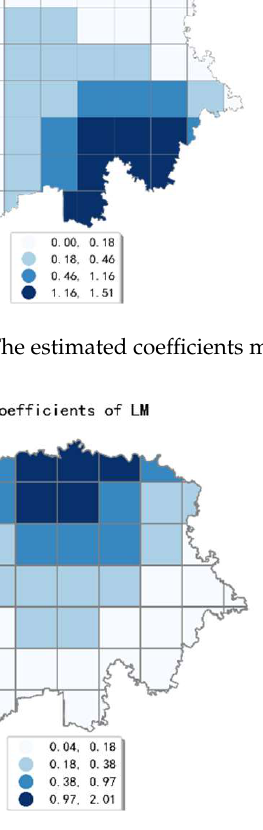
Figure 11. The estimated coefficient maps in the grid with 5000 m.